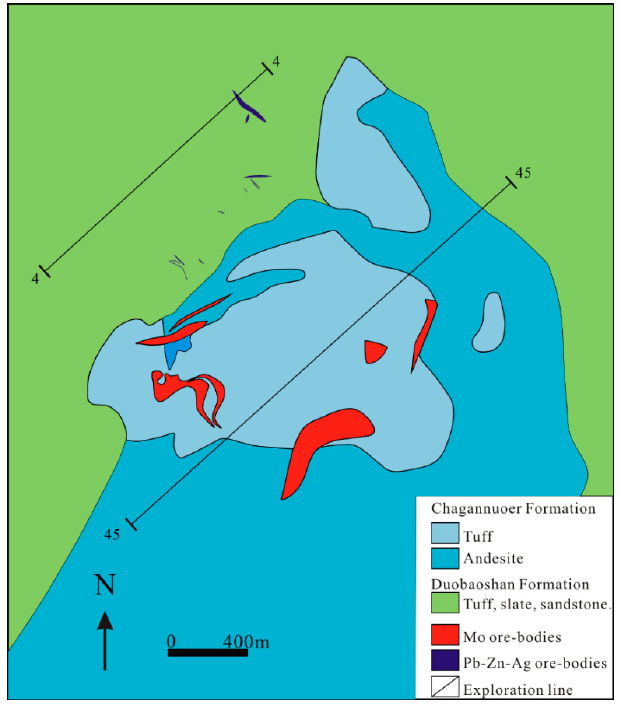
Figure 2. Geologic map of the Diyanqinamu mine (Modified after [24,32]).